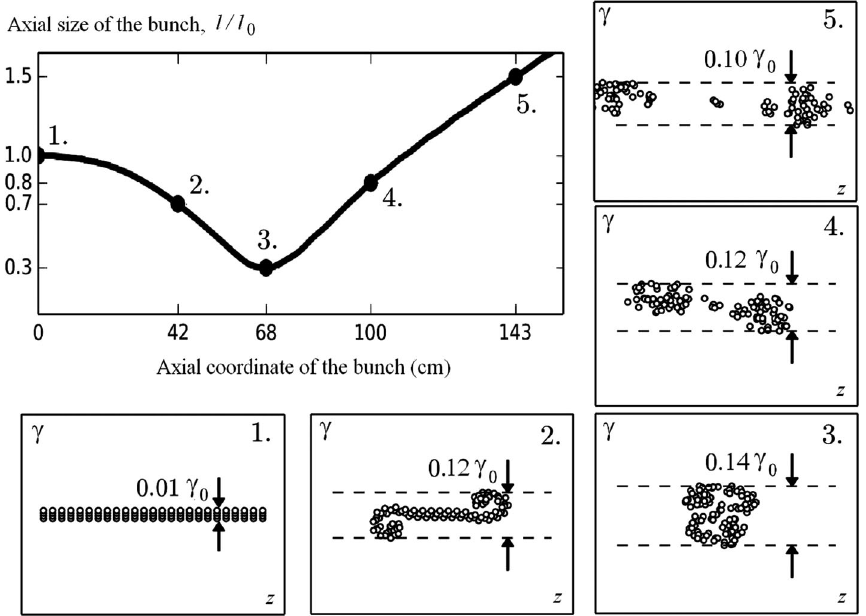
FIG. 9. Dynamics of the electron bunch with an initial length of 1 mm moving through a negative-mass undulator ( Δ ¼ − 0 . 4 ). Effective bunch length normalized to the initial value, l=l 0 , versus the axial coordinate of the bunch, as well as distributions of electrons on the phase planes (energy/axial position) at different stages of the bunch